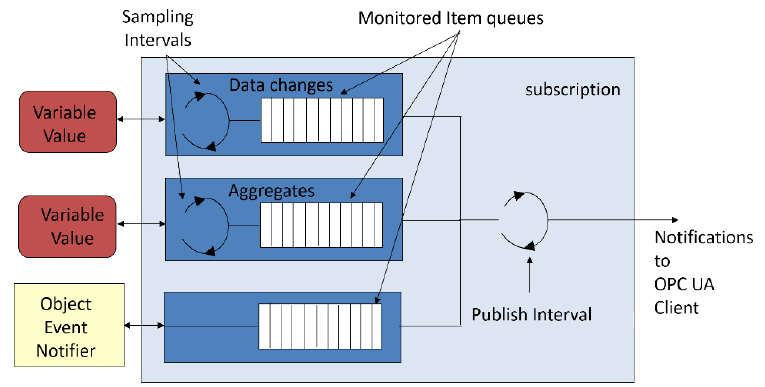
Figure 3. Data buffering in subscription ‐ based communication in OPC UA.